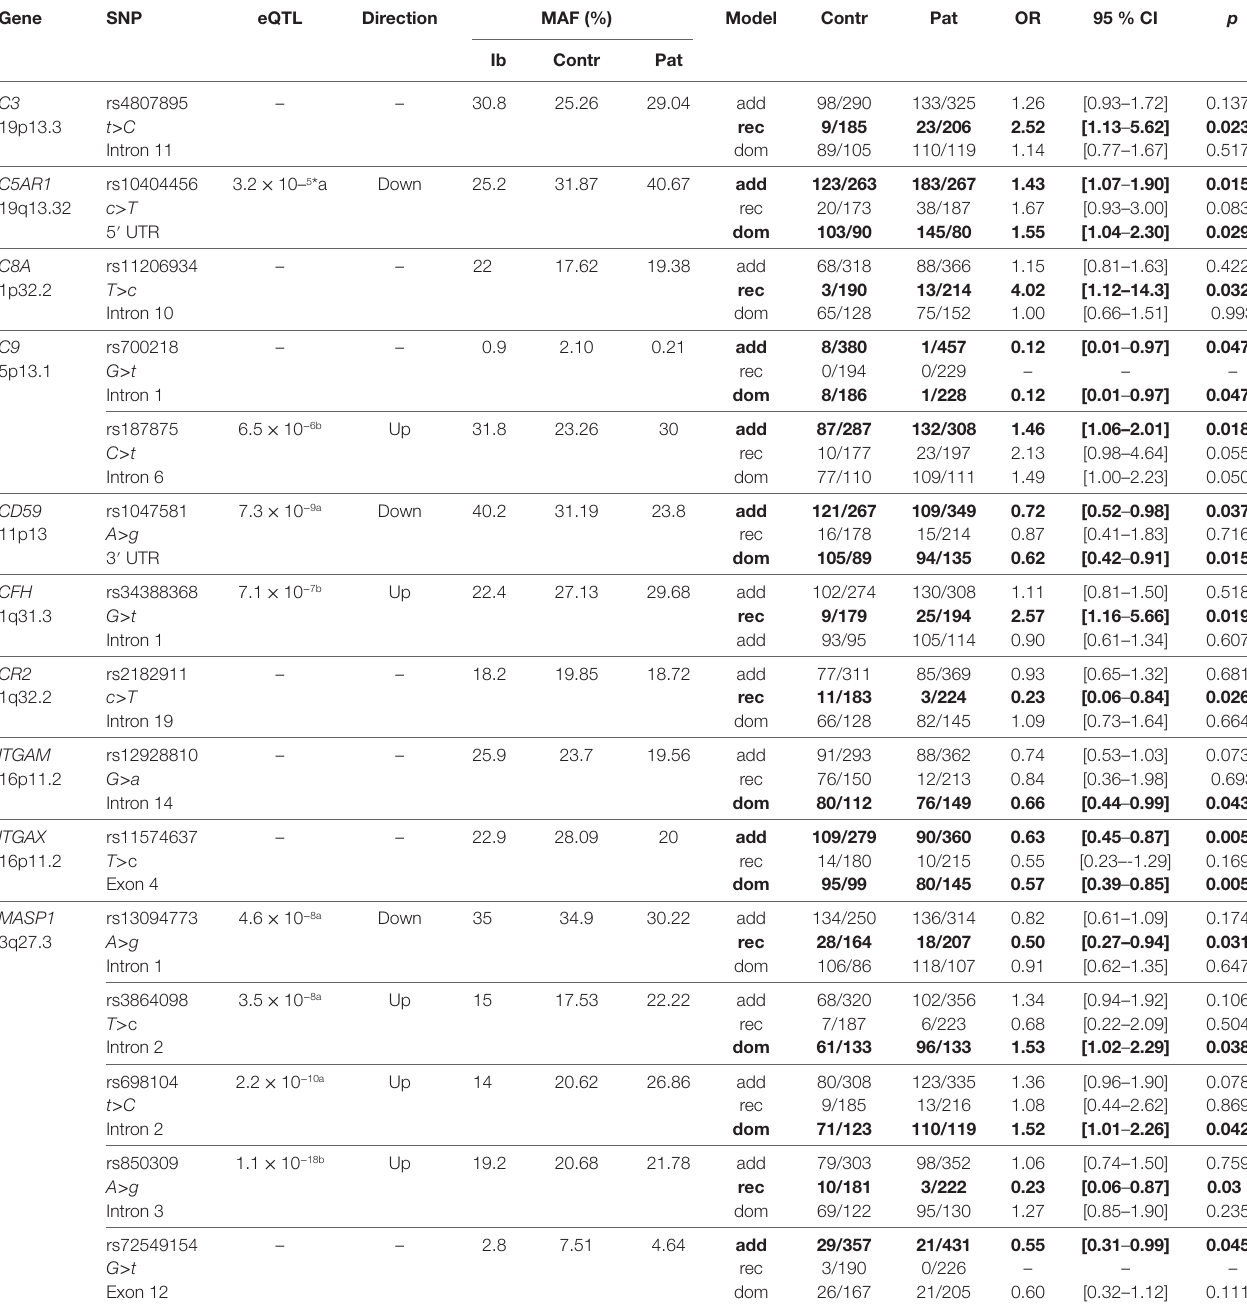
tABLe 1 | Complement gene variants associated with